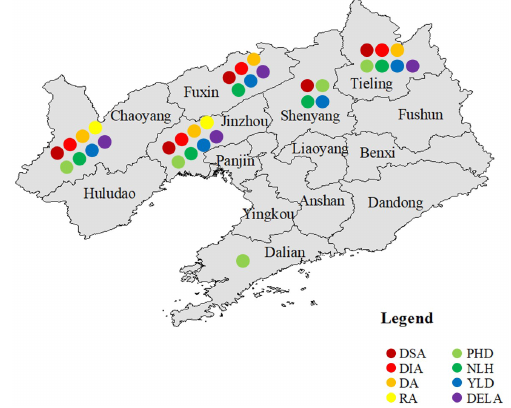
Figure 8. Map showing the drought impacts each city in Liaoning province is most vulnerable to, based on the results of the linear regression. Table 3. The vulnerability factors selected for the stepwise regres- sion model and the R 2 of the resulting model for each impact type (identified by the codes in Table